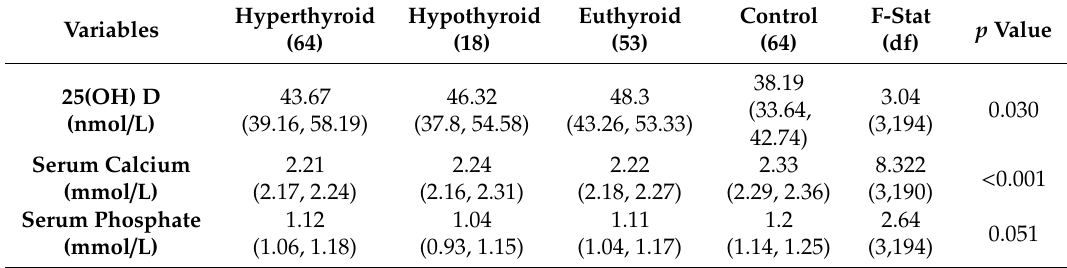
Table 6. ANCOVA analysis adjusted for age and gender. Comparisons of the mean serum 25(OH)D, serum calcium and serum phosphate in between